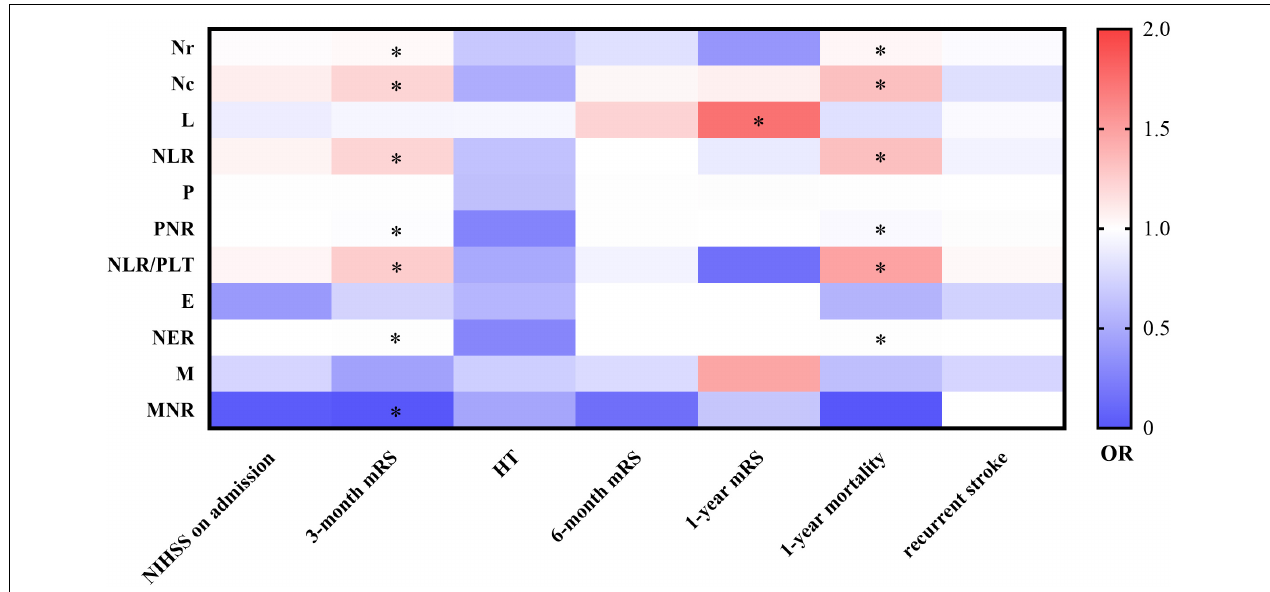
FIGURE 3 | Multivariate logistic regression analyses for prognosis. NIHSS, national institute of health stroke scale; mRS, Modified Rankin Scale; HT, hemorrhagic transformation; OR, odd ratio; Nr, neutrophil ratio; Nc, neutrophil count; L, lymphocyte; NLR, neutrophil-to-lymphocyte ratio; P, platelet; PNR, platelet-to-neutrophil ratio; NLR/PLT, NLR-to-platelet ratio; E, eosinophil; NER, neutrophil-to-eosinophil ratio; M, monocyte; MNR, monocyte-to-neutrophil ratio.